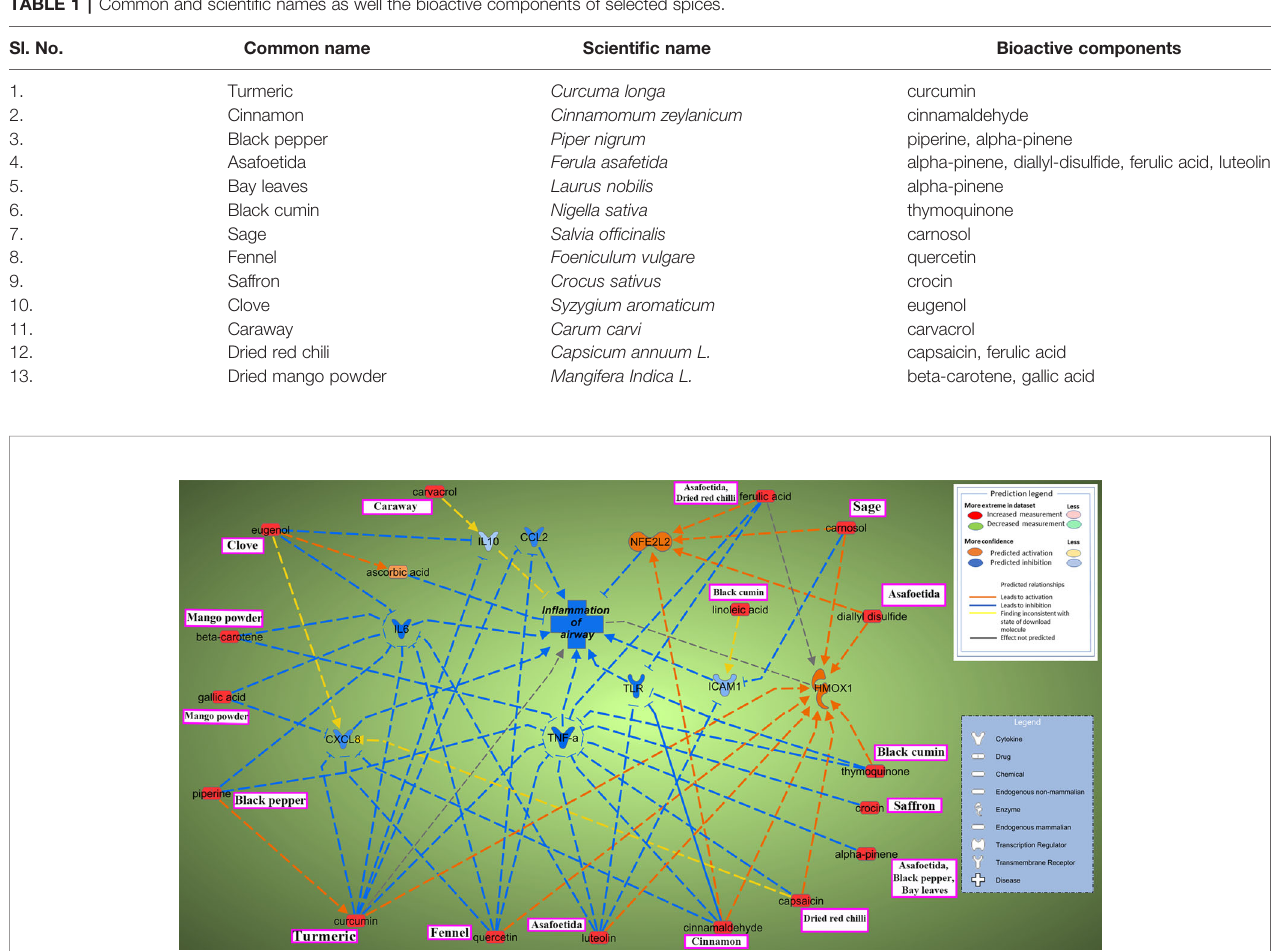
FIGURE 2 | Ingenuity Pathway Analysis reveals interaction between bioactive components in spices and in fl ammation of the airway. Two possible mechanisms depicted through which active components from commonly used spices could help mitigate airway in fl ammation in COVID-19. One pathway involves inhibiting major pro-in fl ammatory cytokines and chemokines such as tumor necrosis factor-alpha (TNF- a ), interleukins (CXCL8 (IL8), IL6, IL10), and chemokine CCL2; blocking in fl ammatory signal onset by inhibiting TLR (toll-like receptors) or inhibiting ICAM-1 (intercellular adhesion molecule 1) dependent migration of immune cells to the site of in fl ammation. Another way bioactive components could maintain in fl ammatory homeostasis is by targeting the oxidative stress pathway via activation of NFE2L2 (nuclear factor erythroid 2-related factor 2; Nrf2) and HMOX1(heme oxygenase 1). Synergistic effects of spices could also be evaluated, for example, between piperine and curcumin in attenuation of COVID-19 linked hyperin fl ammatory response. The name of major spice source(s) for the bioactive components are mentioned in boxes (pink). Interactive network constructed using Ingenuity Pathway Analysis (IPA) software (Qiagen Inc., Germantown, MD). Arrow-head indicates activation; bar-head indicates inhibition. Prediction legend indicates the relationship between